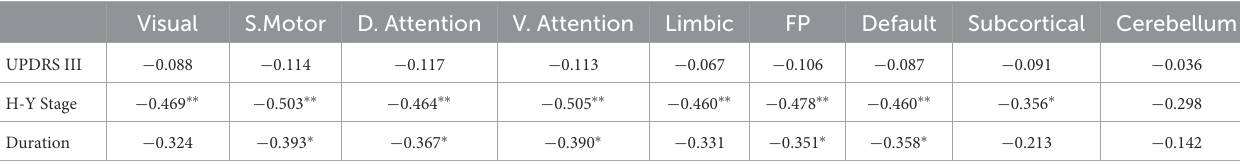
TABLE 2 Spearman’s correlation (rho) between clinical measurements and PSMA FCS with brain networks. Visual